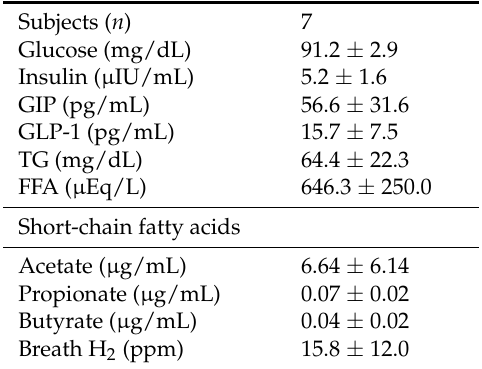
Table 1. Characteristics of the subjects at